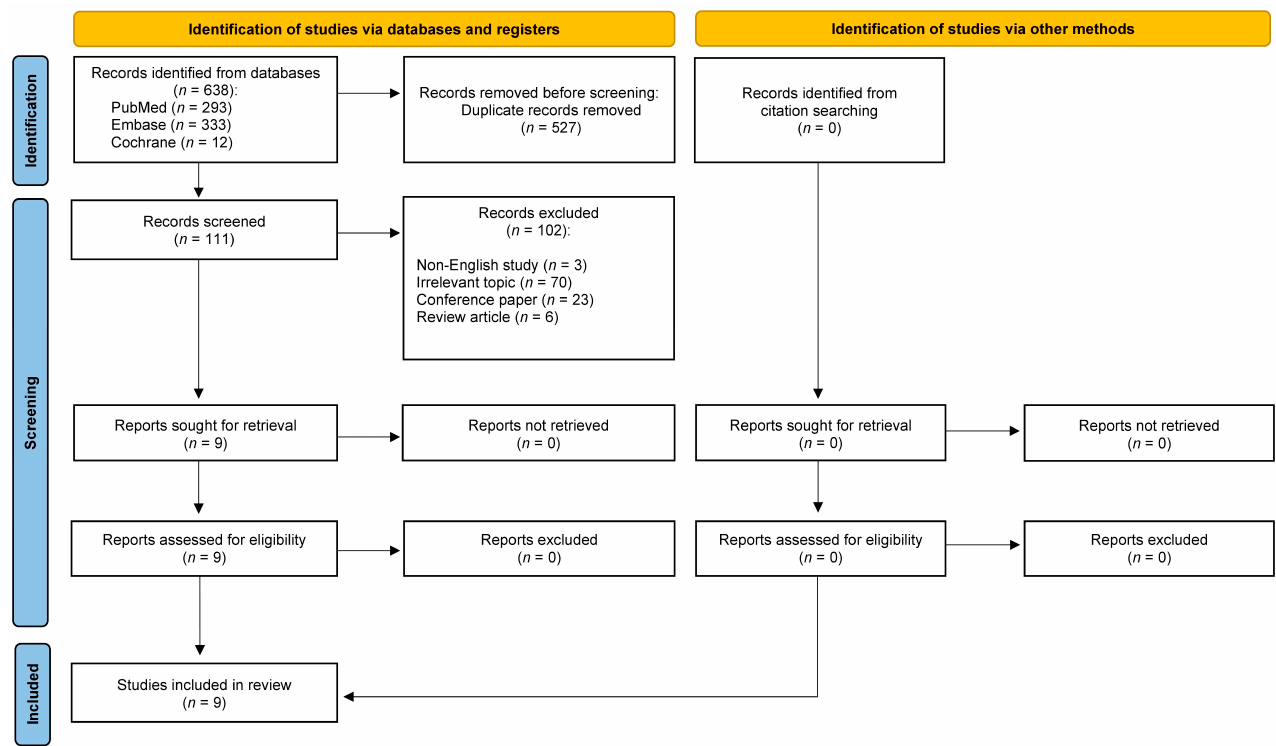
Figure 1. PRISMA fl owchart of the medical database search strategy. Figure 1. PRISMA flowchart of the medical database search